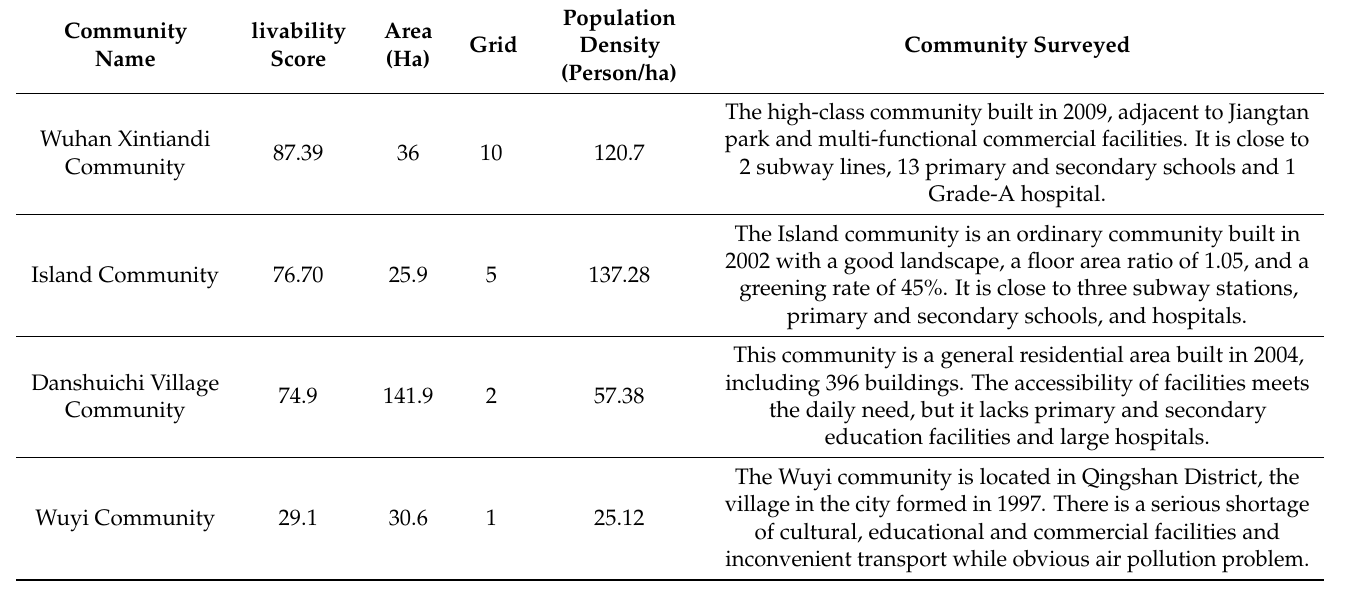
Table 5. Field surveying about grouping